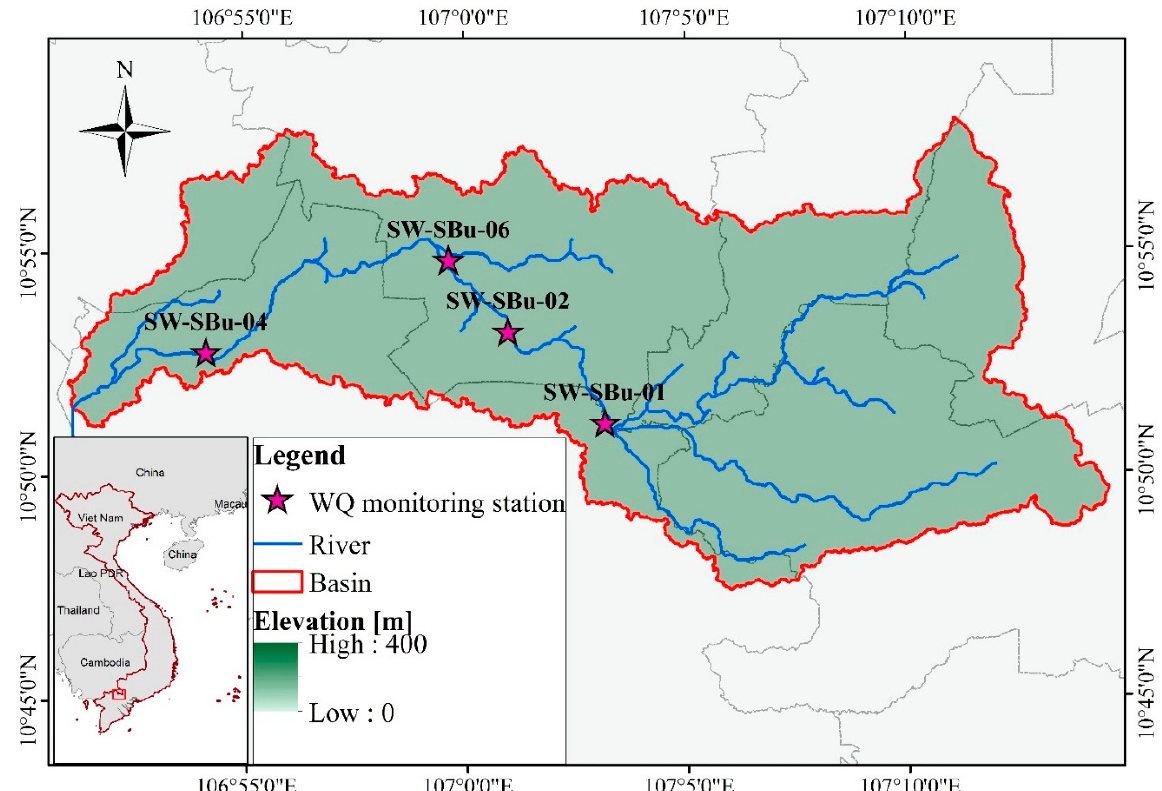
Figure 1. The La Buong River and location of the WQ monitoring stations.